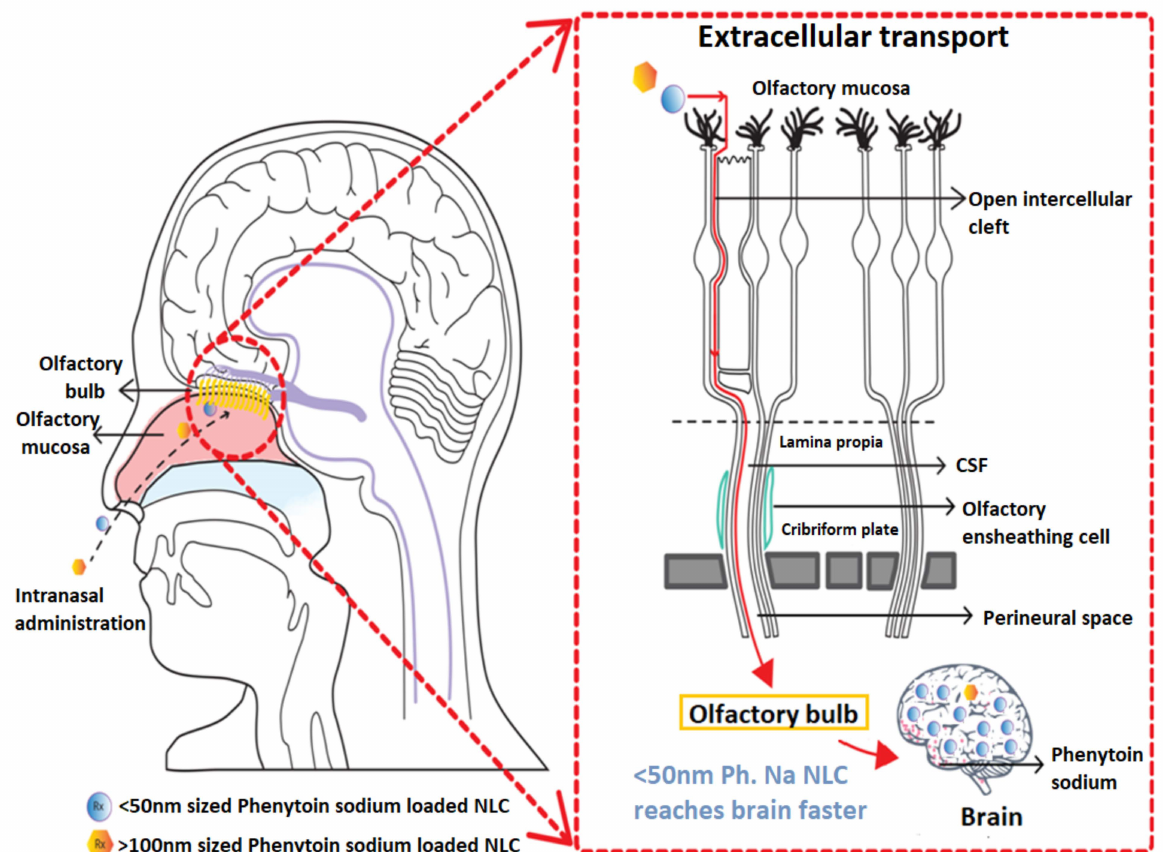
Figure 10. The schematic diagram showing direct nose to brain delivery of phenytoin sodium NLCs through olfactory epithelium by the extracellular perineural transport